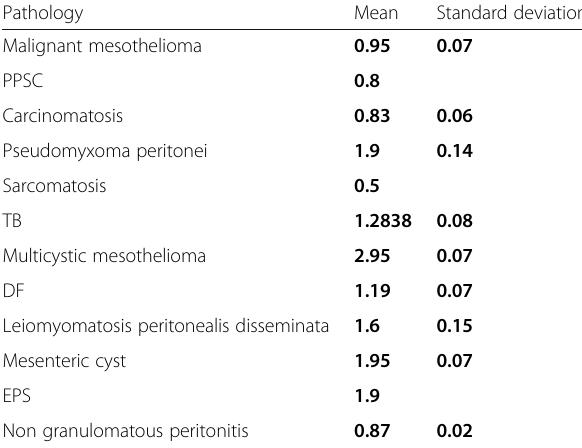
Table 3 Mean and standard deviation of average ADC values in different peritoneal pathologies Pathology Mean Standard deviation Malignant